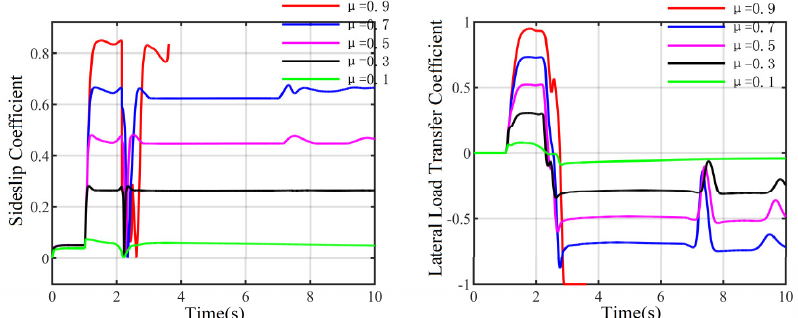
Figure 5. Comparison of ρ and the load transfer ratio (LTR) under different road adhesion coefficients (Fishhook condition).